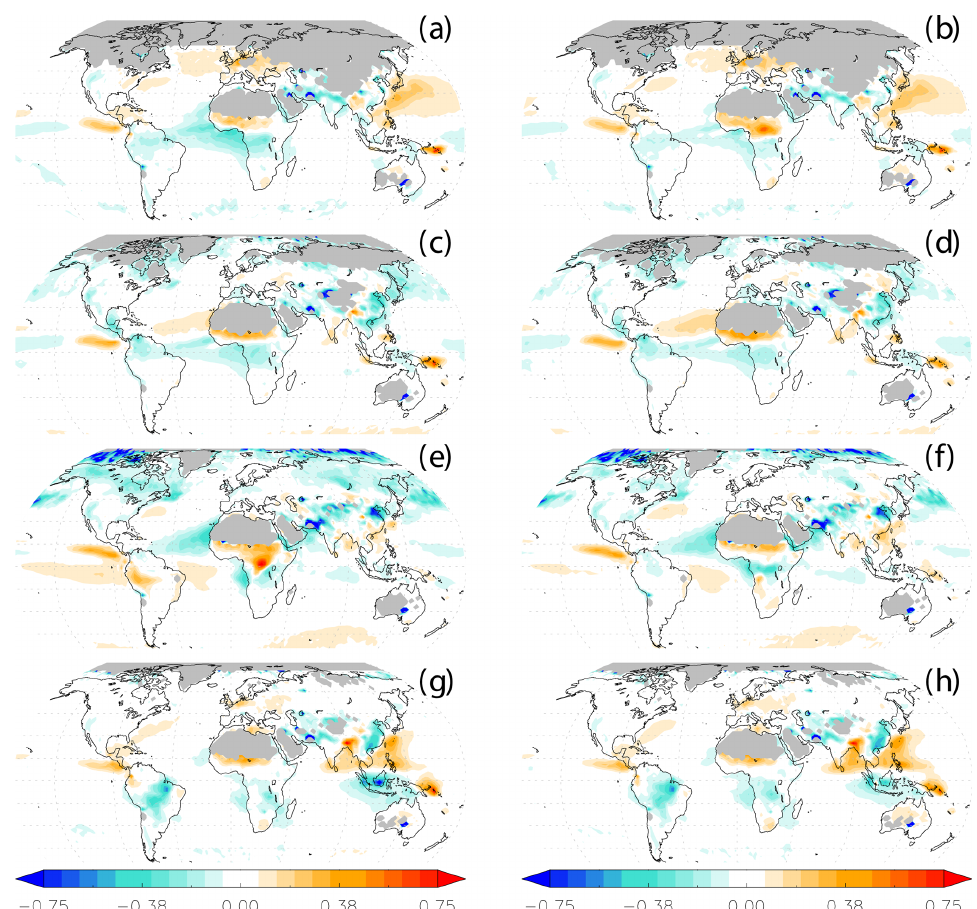
Figure 11. The difference in monthly modeled clear-sky aerosol optical depth (AOD) and MODIS Aqua (model – satellite). Model simula- tions using pyrE fire emissions (left) and model simulations using offline GFED4s emissions (right) are shown: January (a, b) , April (c, d) , July (e, f) , and October (g, h) . The difference is based on an ensemble of 10 simulations and 2003–2007 MODIS climatological monthly data. Missing MODIS data are shaded in light gray.